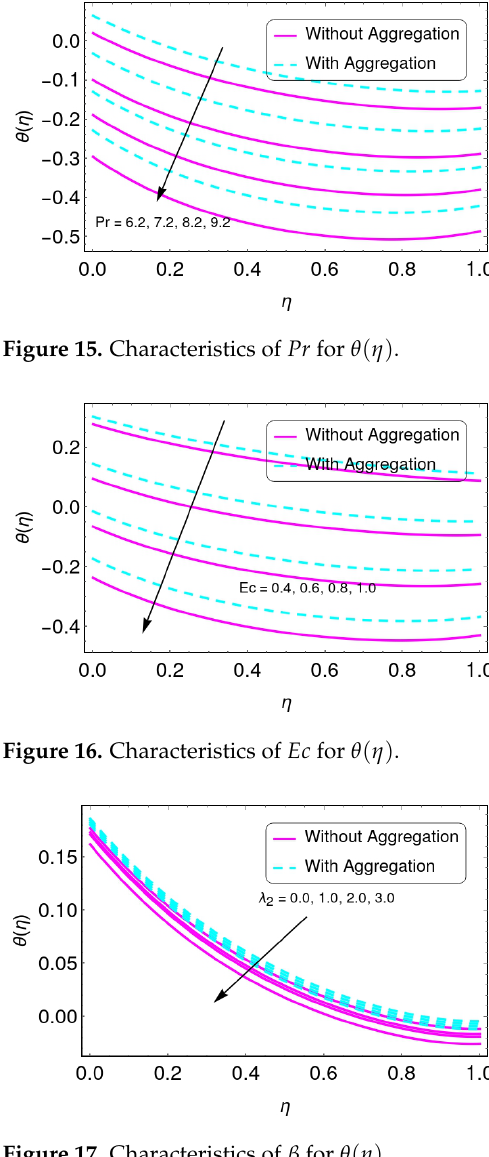
Figure 17. Characteristics of β for θ ( η )